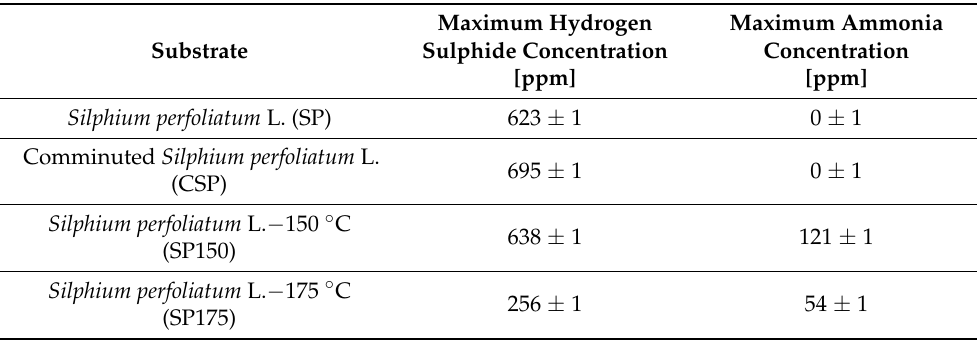
Table 7. The maximum concentrations of hydrogen sulphide and ammonia in the biogas during the anaerobic digestion of the comminuted and non-comminuted